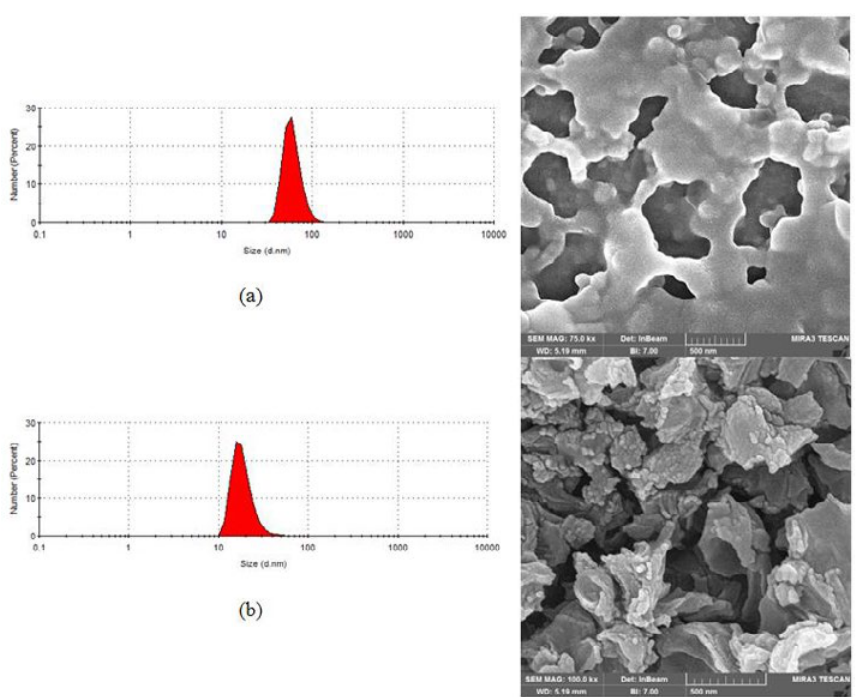
Fig. 2. DLS and FESEM analysis of BaSO